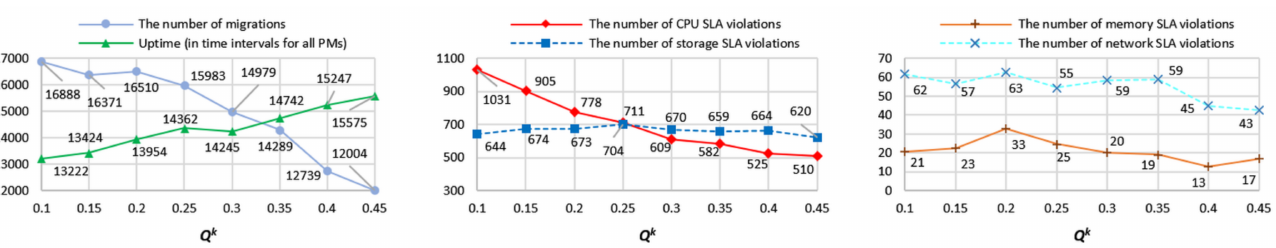
Figure 6. The effect of D k on the quality metrics for power consumption minimization. Next, with the fixed values of L k = 0.35, T k = 0.03, and D k = 0.9, the effect of Q k on the quality metrics is determined. Q k takes values as shown in Table 2. The optimal value in terms of power consumption is Q k = 0.1 (Figure 7) since the minimum uptime of PMs is observed.